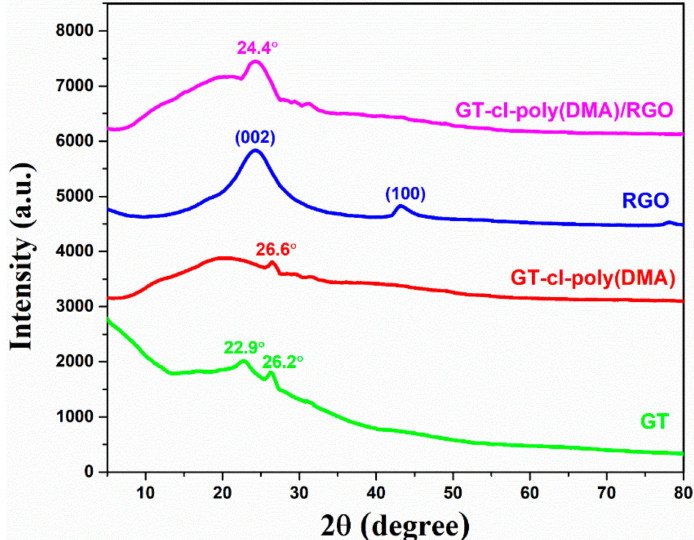
Figure3. X-raydi ff ractionpatternforgumtragacanth(GT),gumtragacanth-cl- N,N -dimethylacrylamide (GT-cl-poly(DMA)) hydrogel, RGO and reduced graphene oxide incorporated gum tragacanth-cl- N,N -dimethylacrylamide (GT-cl-poly(DMA) / RGO) hydrogel